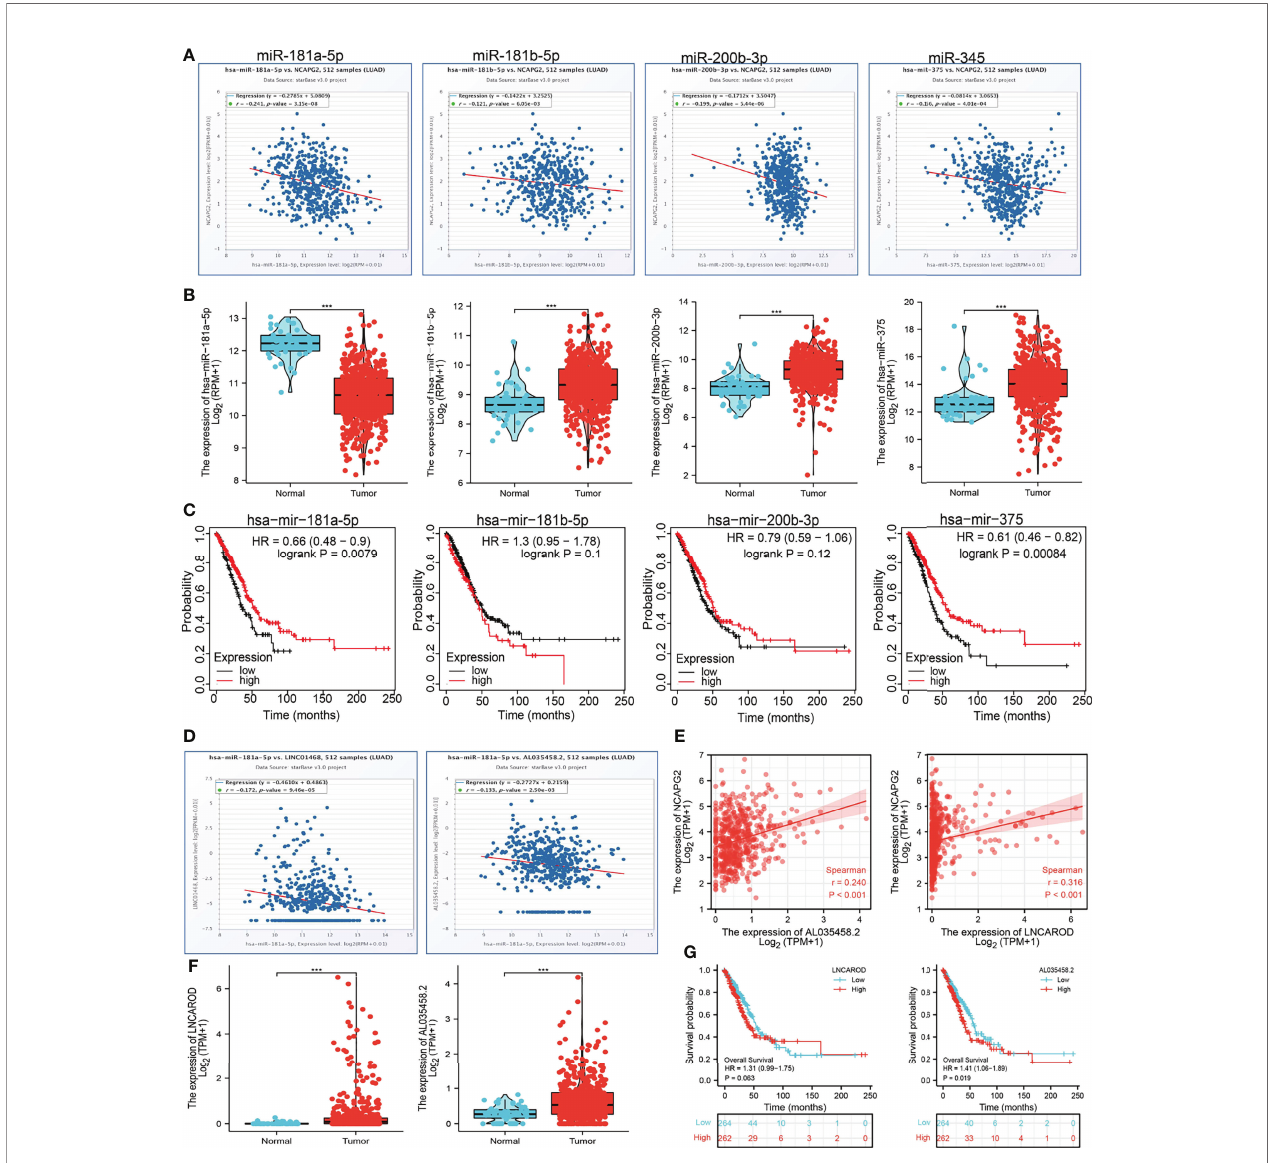
FIGURE 12 | LncRNA/hsa-miR-181a-5p/NCAPG2 regulatory network. (A) Analysis of the correlations between NCAPG2 expression and hsa-miR-181a-5p, hsa-miR-181b- 5p, hsa-miR-200b-3p, and hsa-miR-345 in TCGA-LUAD. (B) Analysis of hsa-miR-181a-5p, hsa-miR-181b-5p, hsa-miR-200b-3p, and hsa-miR-345 expression in lung cancer and adjacent normal tissues in the TCGA database. (C) Association between hsa-miR-181a-5p, hsa-miR-181b-5p, hsa-miR-200b-3p, and hsa-miR-345 expression and LUAD patients ’ outcomes. (D) Correlations between hsa-miR-181a-5p expression and AL035458.2 and LINC01468 in LUAD. (E) Correlations between NCAPG2 expression and AL035458.2 and LINC01468 in LUAD. (F) Analysis of AL035458.2 and LINC01468 expression in lung cancer and adjacent normal tissues in the TCGA database. (G) Association between AL035458.2 and LINC01468 expression and LUAD patients ’ outcomes. *** p <